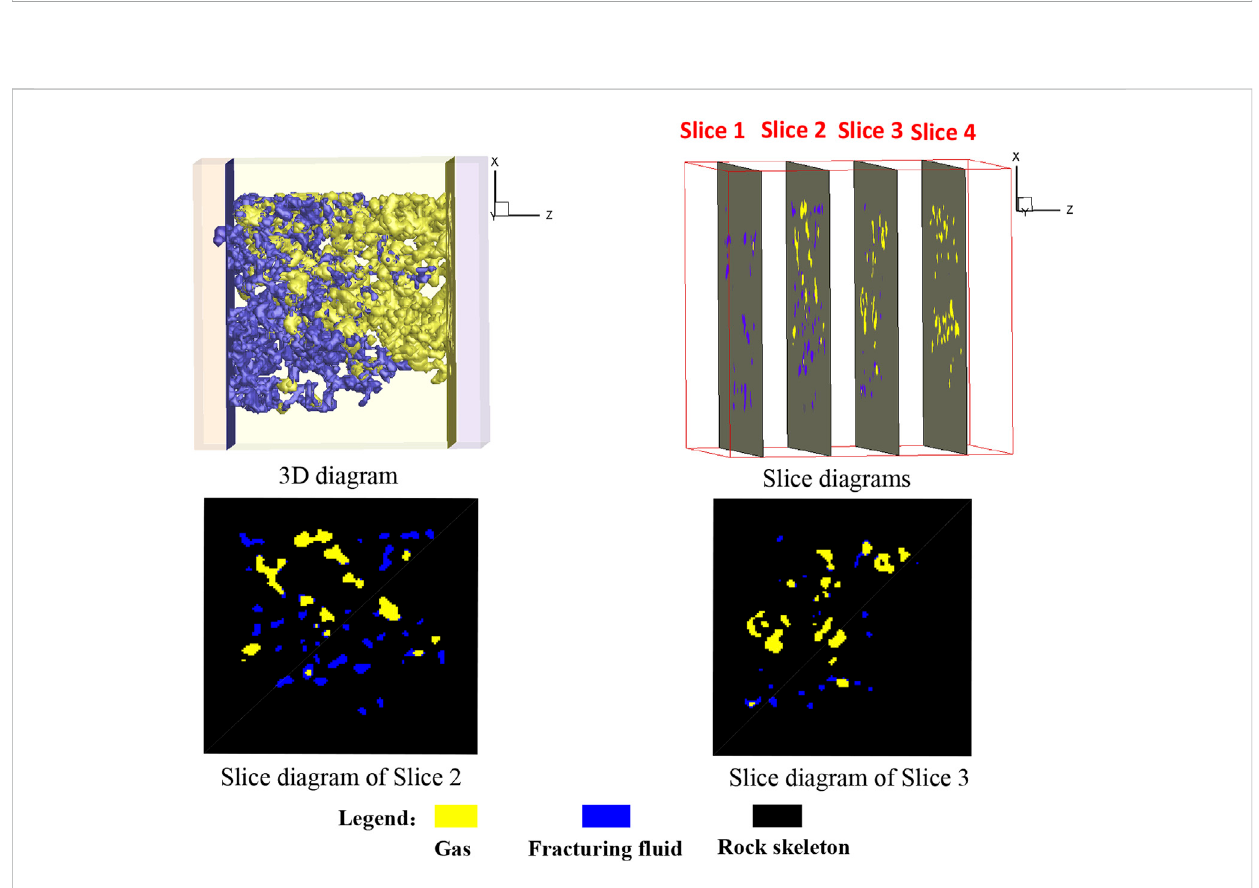
FIGURE 9 Slice diagrams of gas-liquid distribution at the equilibrium state ( t (cid:2) 4 . 0 × 10 6 ) in the fl owback process.